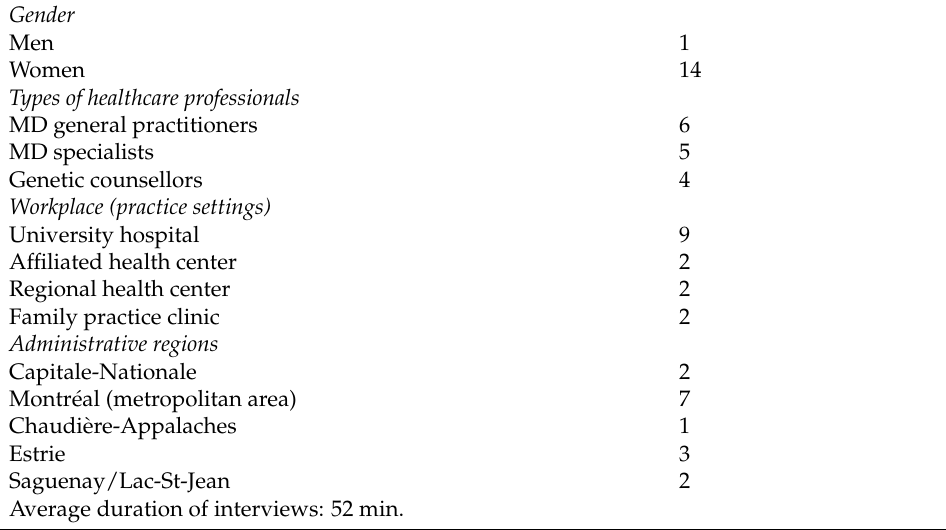
Table 2. Characteristics of the sample ( n =